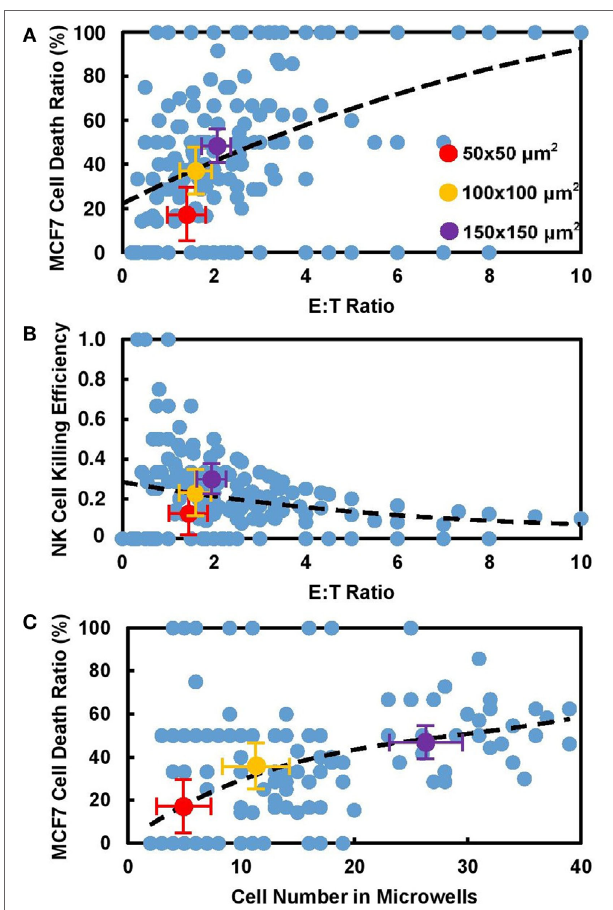
FigUre 3 | Cytotoxicity of natural killer (NK) cell increased with number of cells confined in microwells. Experiment data obtained from all individual microwells (blue) and average value from 50 μ m × 50 μ m (red), 100 μ m × 100 μ m (yellow), and 150 μ m × 150 μ m (violet) microwells were displayed. (a) MCF7 cell death ratio increased with E:T ratio in microwells. (B) Killing capability of NK cells decreases with E:T ratio in corresponding microwells. Larger dots show average values in different sizes. (c) MCF7 cell death ratio increased with number of cells in microwells regardless of their